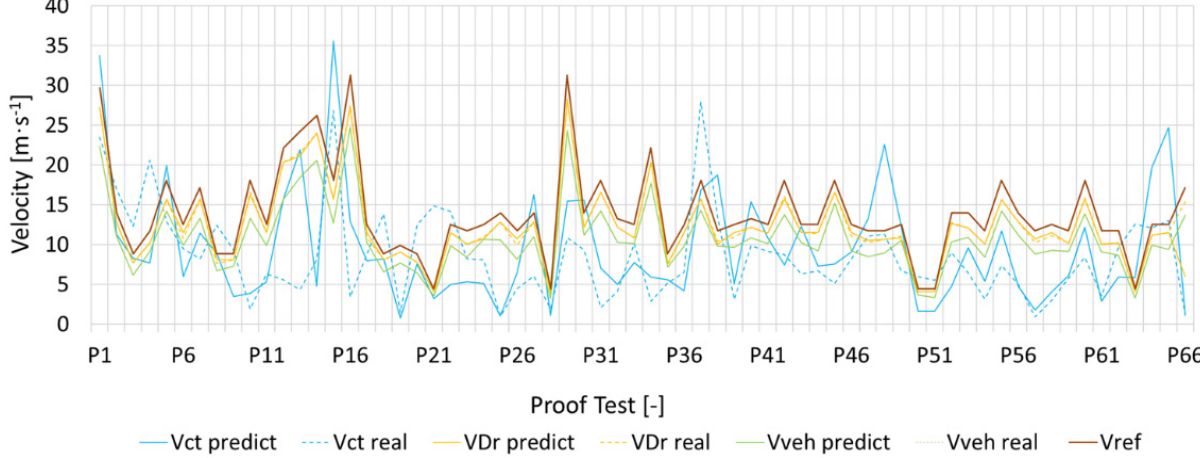
Figure 10. Predicted velocity vs. referent and real velocity.